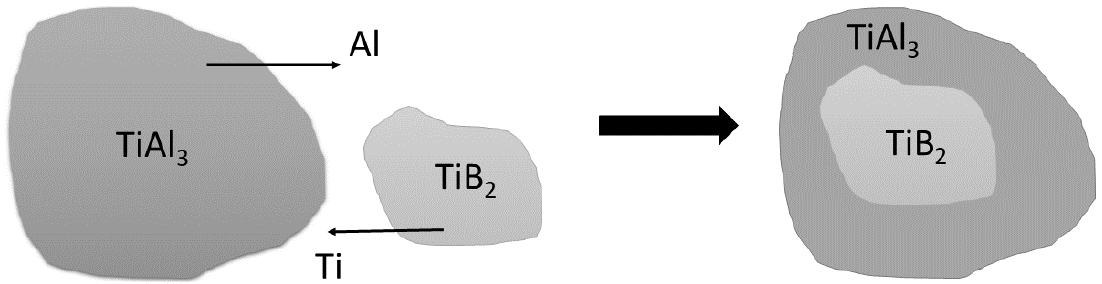
Figure 1. Graphical representation of the dissolution of TiAl 3 intermetallic